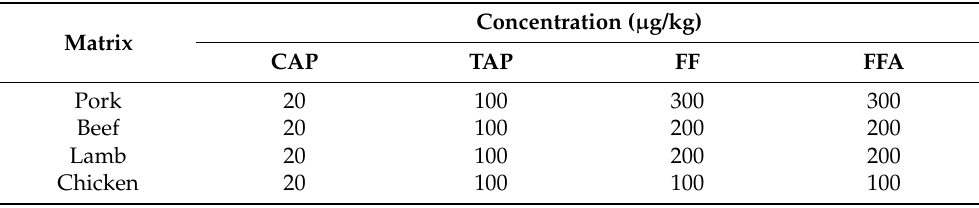
Table 2. Spiked concentrations of amphenicols and metabolites in positive mock